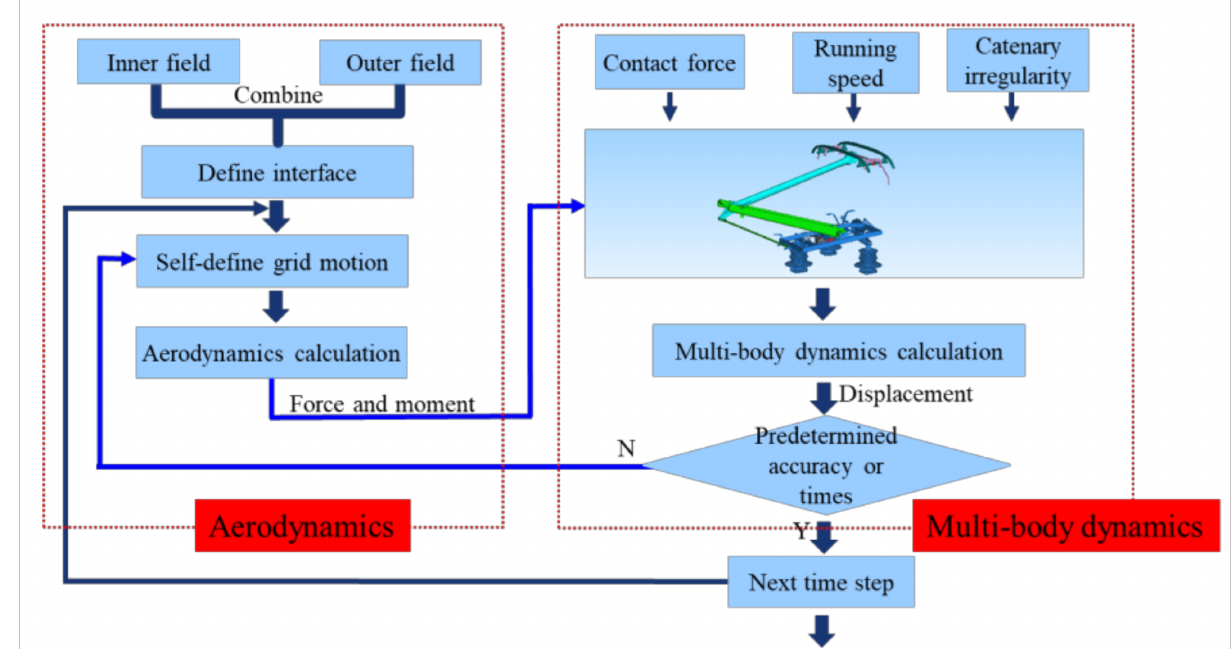
Figure 8. Flow chart of the coupling between aerodynamics and multi-body dynamics adapting to high-speed